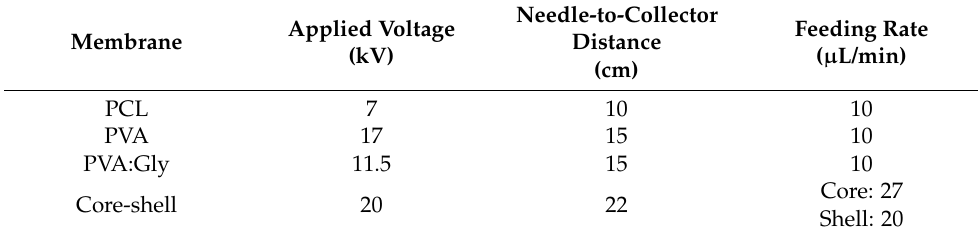
Figure 1. ( a ) Electrospinning device used for membrane fabrication; ( b ) coaxial electrospinning needle and core-shell fiber structure. Table 1. Electrospinning parameters of the fabricated membranes.